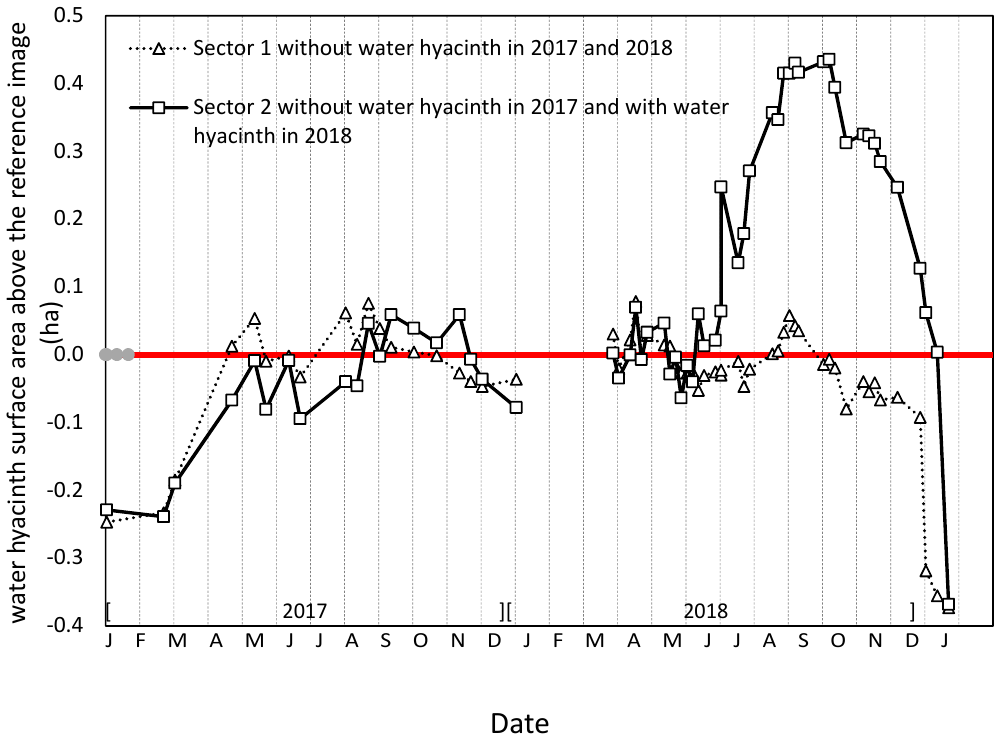
Figure 5. Residue histogram between the FVC values of the component images (FVCn) and those of their mean (FVCref).